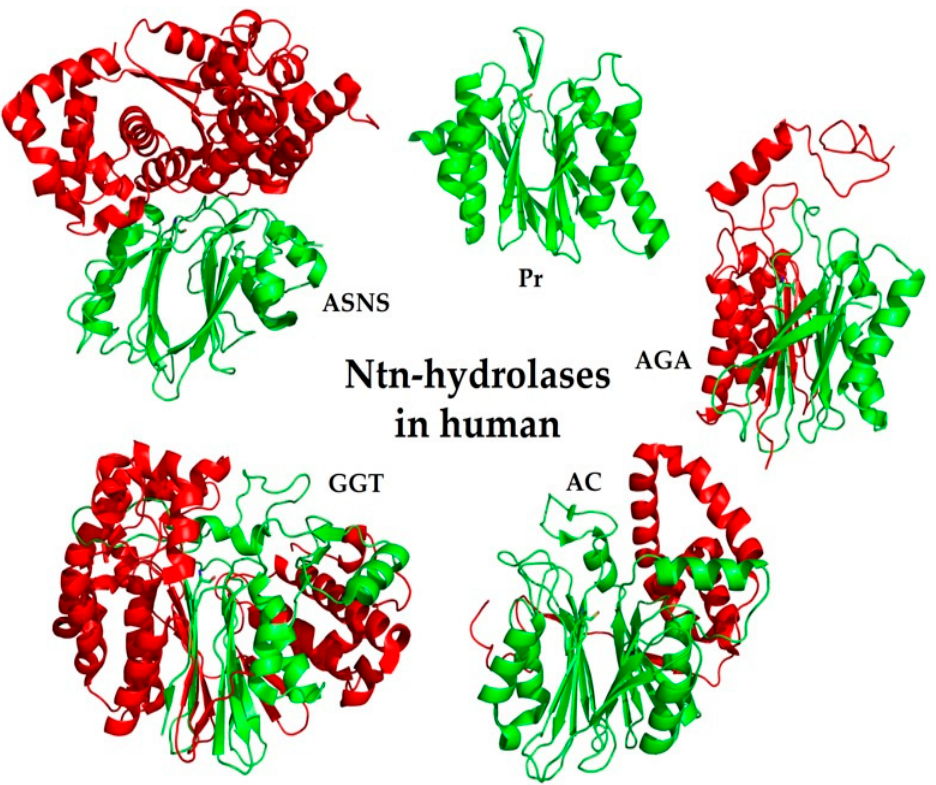
Figure 3. Representative 3-D structures of human Ntn-hydrolases. Three-dimensional structure of asparagine synthetase (ASNS, PDB 6GQ3), acid ceramidase (AC, PDB 5U7Z), proteome β -subunit (Pr, PDB 4r3O), lysosomal aspartyl glucosaminidase (AGA, PDB 1APY), and γ -glutamyl-transpeptidases (GGT1, PDB 4GDX). α -subunits are marked in red; β -subunits are marked in green.